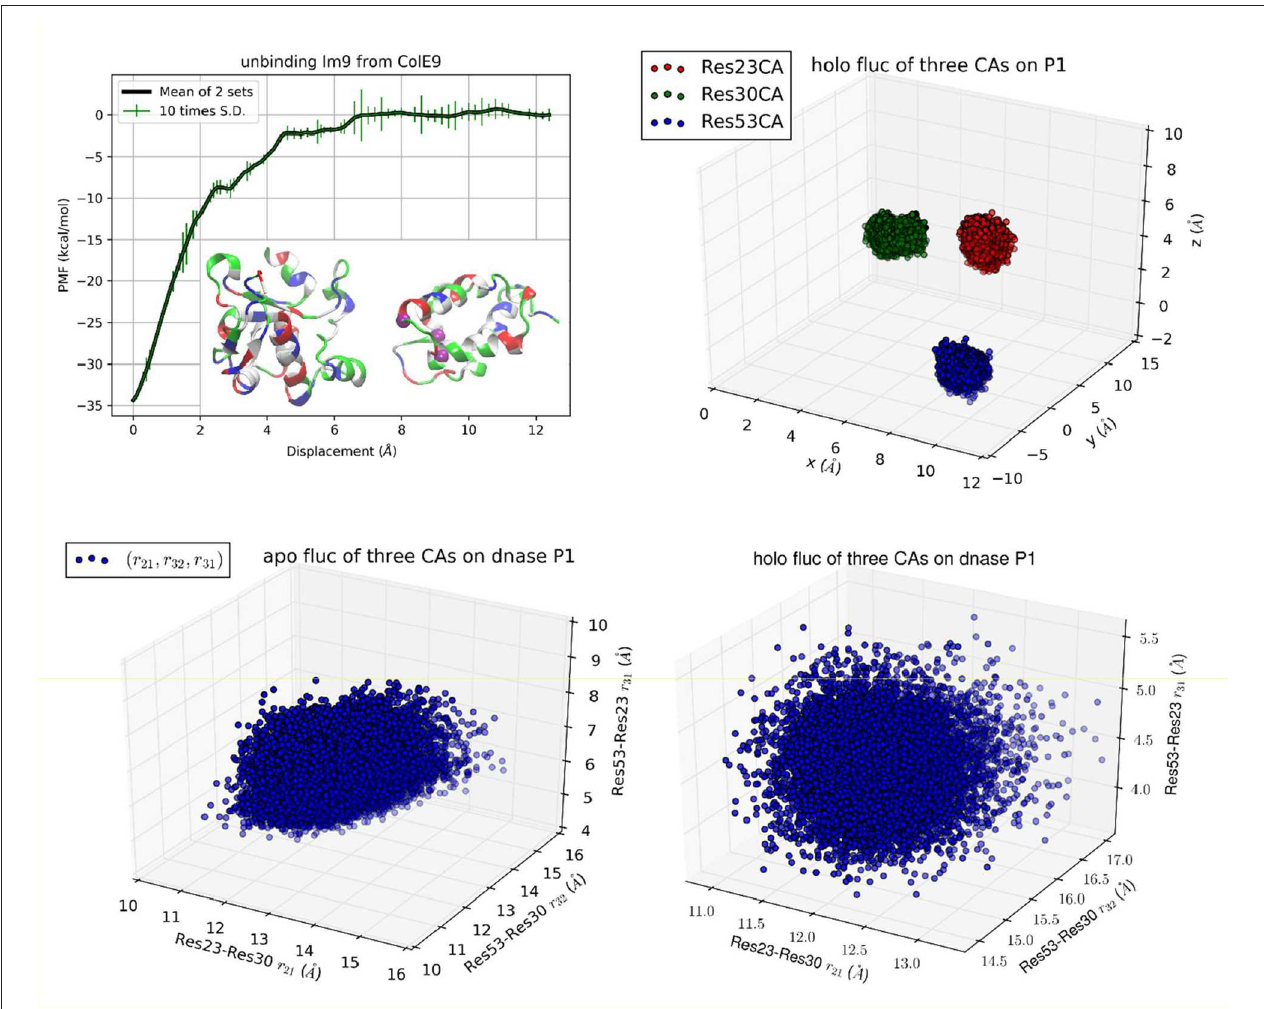
FIGURE 3 | Unbinding Im9 immunity protein from Colicin E9 DNase with Protocol 3. Shown in the upper left panel is the PMF curve of unbinding Im9 from E9. Insets: Im9 and E9 in the unbound state are shown in ribbons colored by residue types (hydrophobic, white; hydrophilic, green; negatively charged, red; positively charged, blue). The three centers ( α -carbons) on Im9 (Cys23C α , Glu30C α , and Ile53C α ) are marked as purple balls, whose coordinates represent the position and orientation of Im9. The upper right panel shows the fluctuations of the three centers in the bound state in terms of their coordinates: ( x 1, y 1 , z 1 ), ( x 2, y 2 , z 2 ), and ( x 3, y 3 , z 3 ). The lower left/right panel shows their fluctuations in the unbound/bound state in terms of three mutual distances: ( r 21 , r 32 , r 31 ).